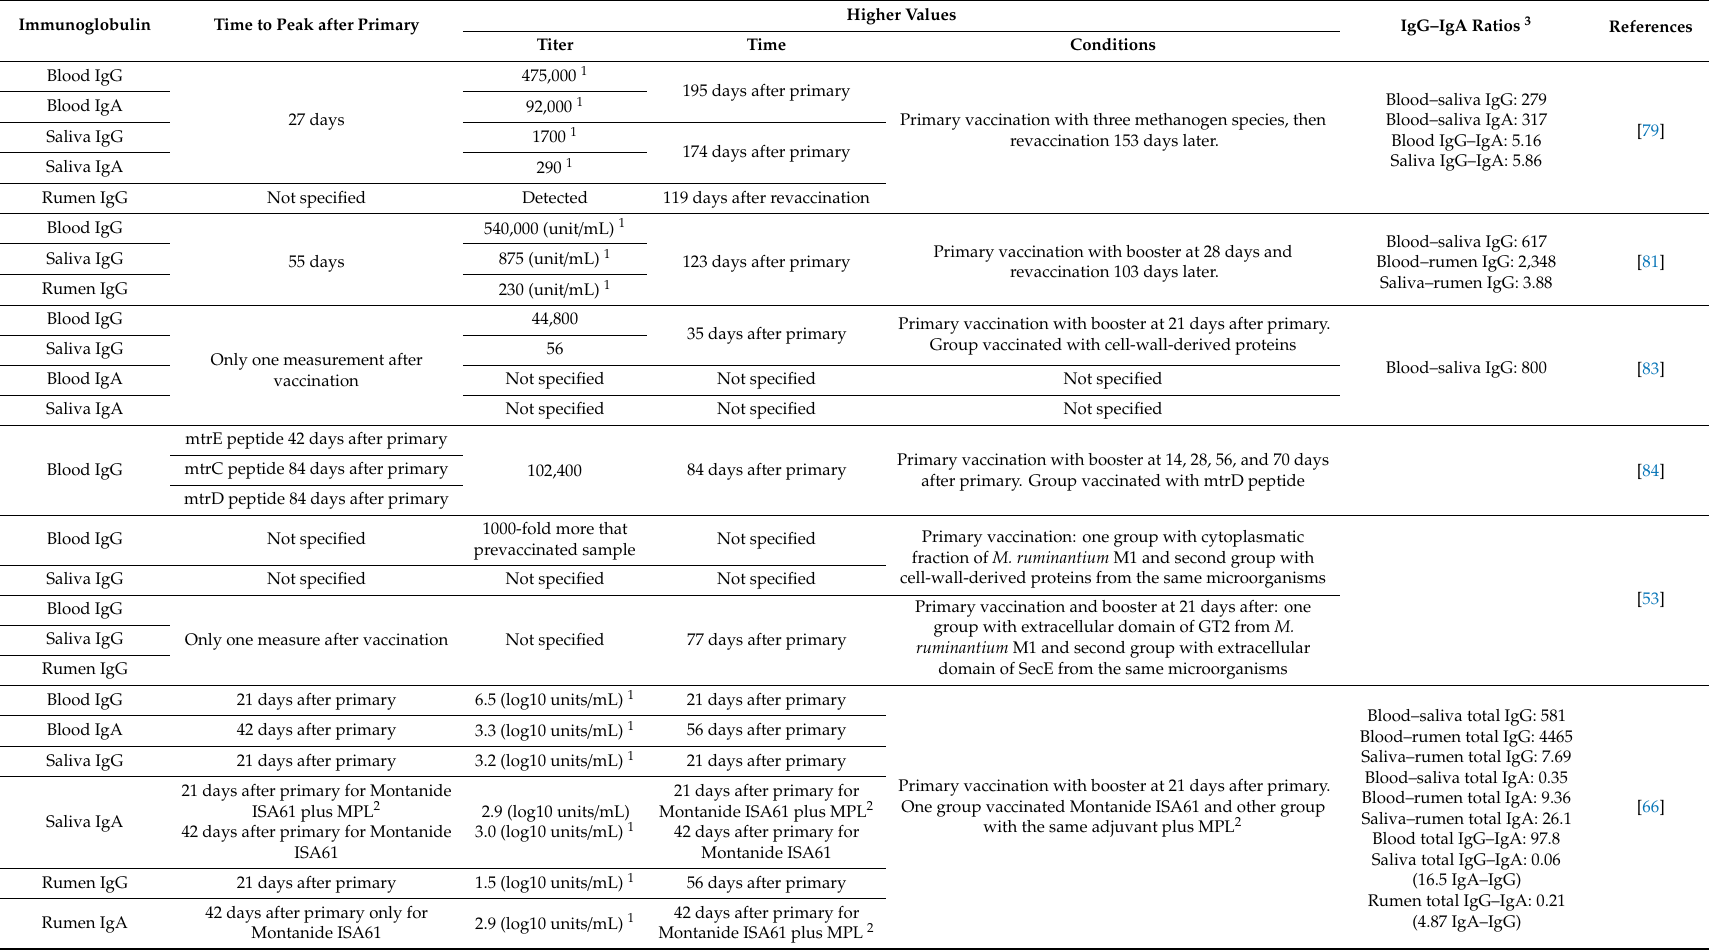
Table 2. Summary of immunoglobulin use in research into vaccination for methane mitigation in ruminants.